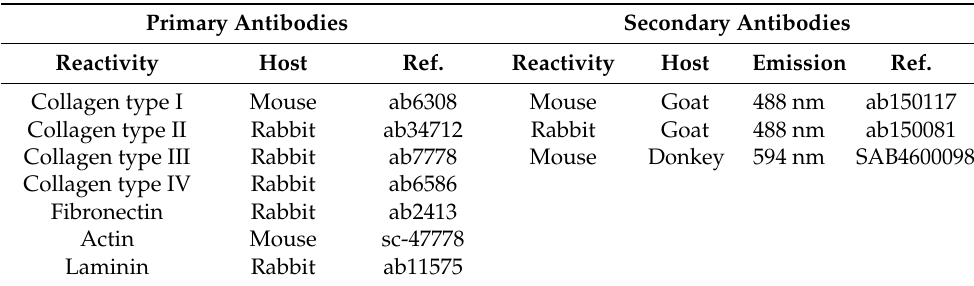
Table 1. Antibodies used in immunofluorescent